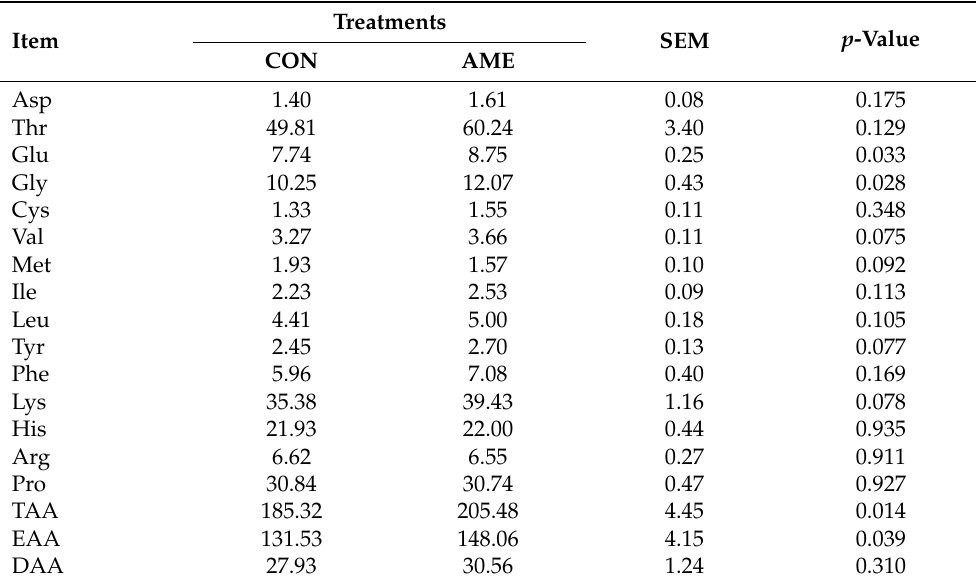
Table 5. Effect of AME on free amino acids composition in LD muscle of lambs (fresh sample basis mg/100